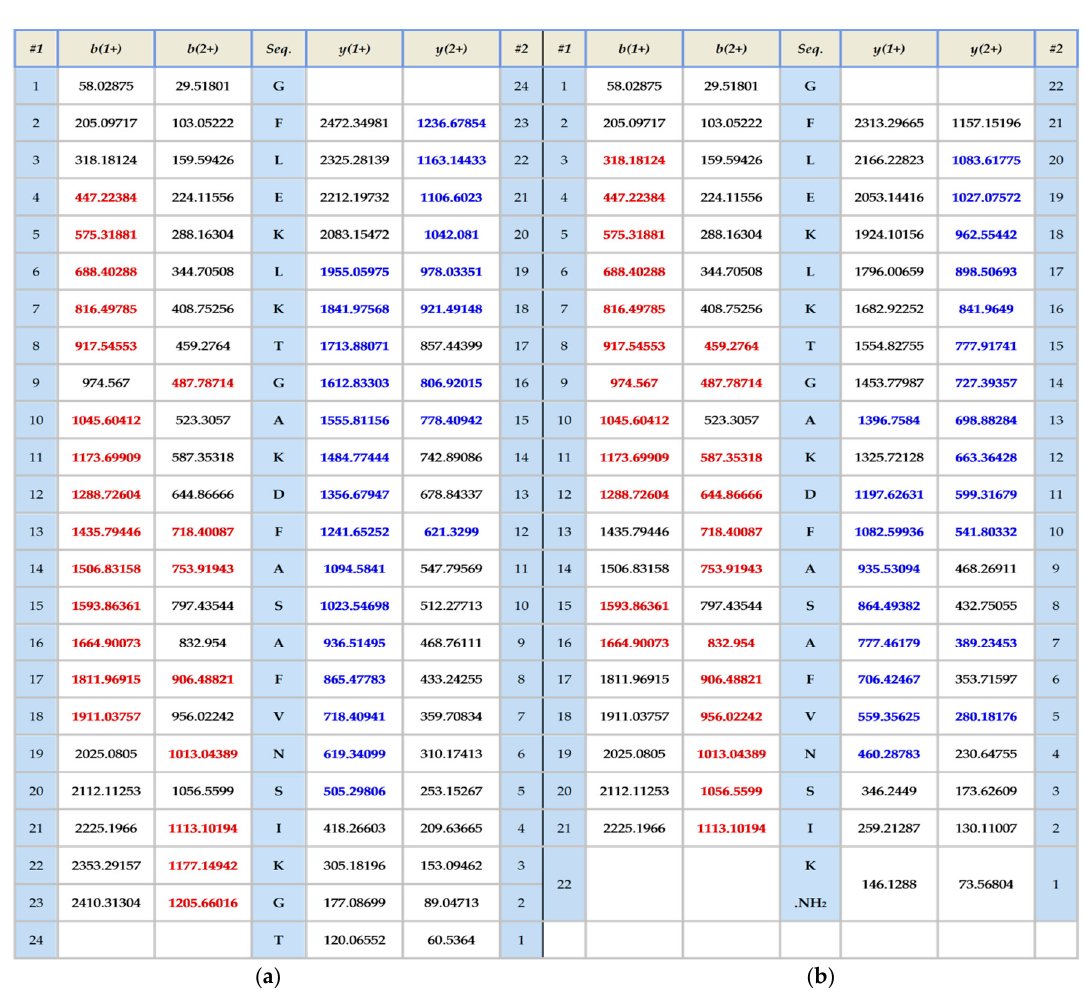
Figure 3. MS/MS fragmentation datasets of fragment ions corresponding to those of frenatin 4.1 ( a ) and frenatin 4.2 ( b ). Expected singly- and doubly-charged b-ion and y-ion fragment m / z ratios were predicted online using Protein Prospector [5]. Observed fragment ions are indicated in red- and blue-coloured typefaces.